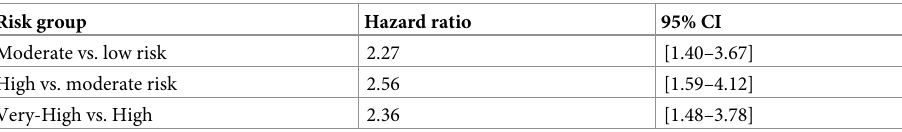
Table 5. Model discrimination: Hazard ratio across risk